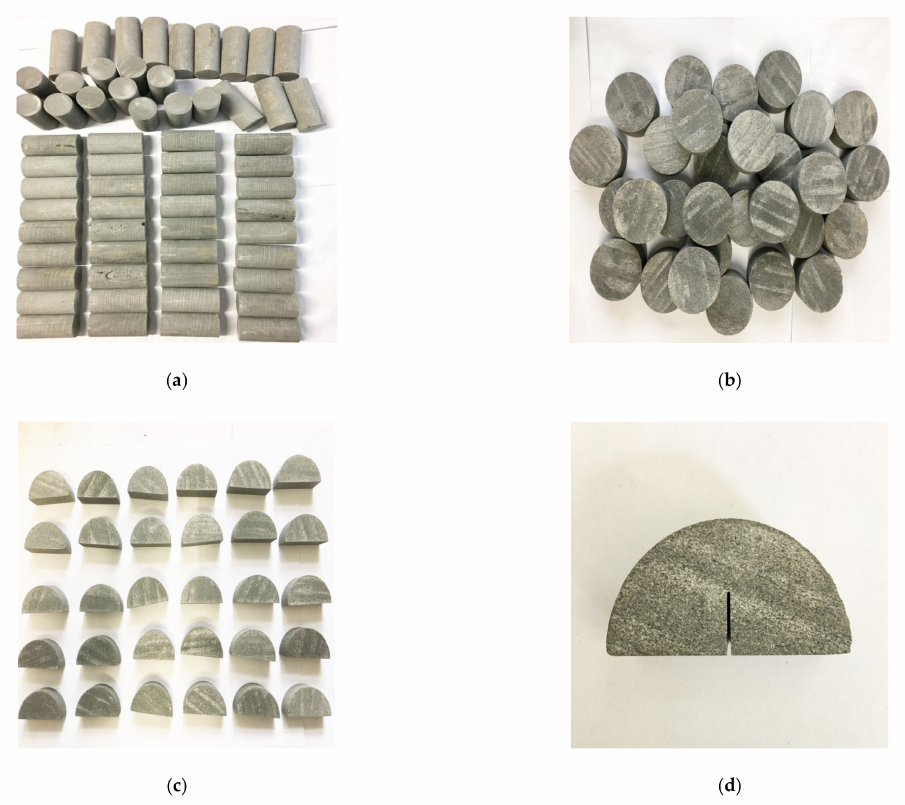
Figure 2. Processing and instruments. ( a ) Cylindrical samples; ( b ) Brazilian disc samples; ( c ) Micro milling; ( d ) Semi-circular bend sample. Table 1. Geometrical dimensions of SCB